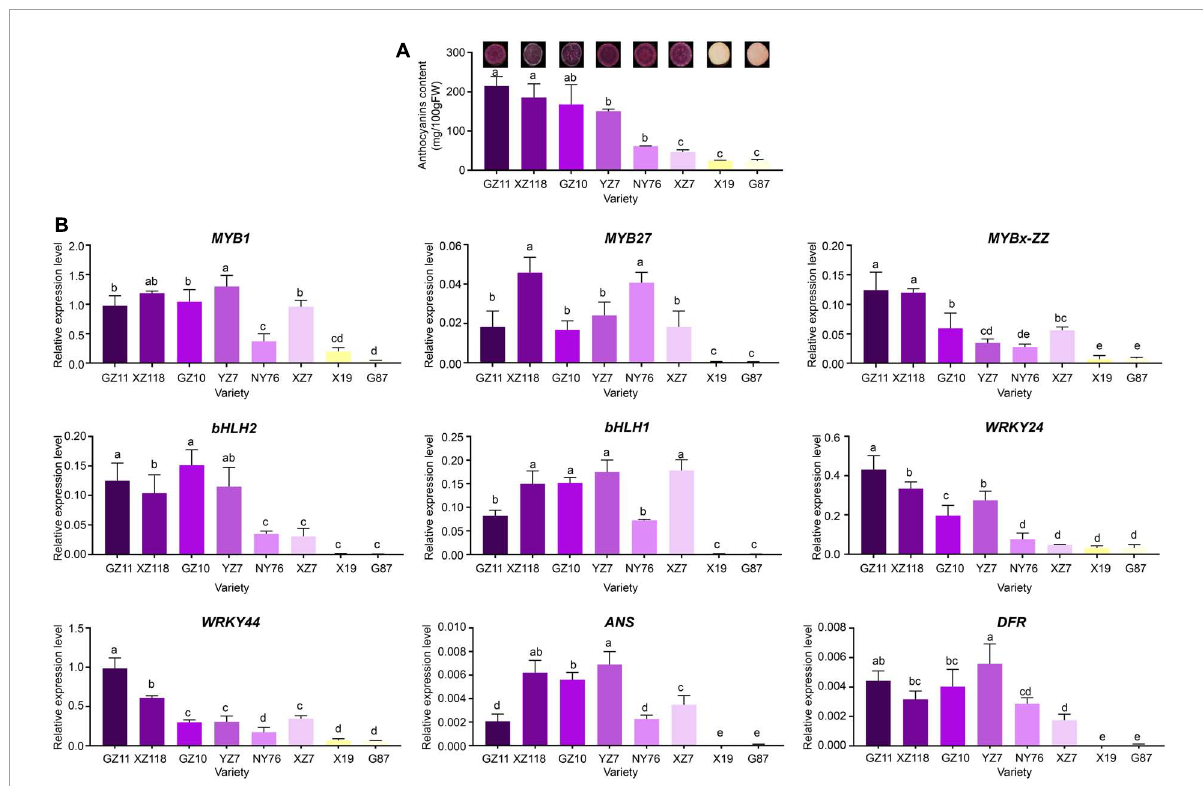
FIGURE6 Total anthocyanin concentration and relative expression levels of key genes in various sweet potato accessions. (A) Cross-section of mature tuberous roots flesh and anthocyanin contents of the eight cultivars. The X-axis represents the cultivars, and the Y-axis represents the contents of anthocyanins. (B) Relative expression level of TFs and structural genes in the tuberous roots of the eight cultivars. The X-axis represents the gene, and the Y-axis represents the relative expression level of the gene. Error bars indicate the standard deviation from three biological replicates. Statistical significance was determined by one-way ANOVA ( P -values reported). Significant differences between means (Duncan, P < 0.05) were indicated by different letters above the bar.